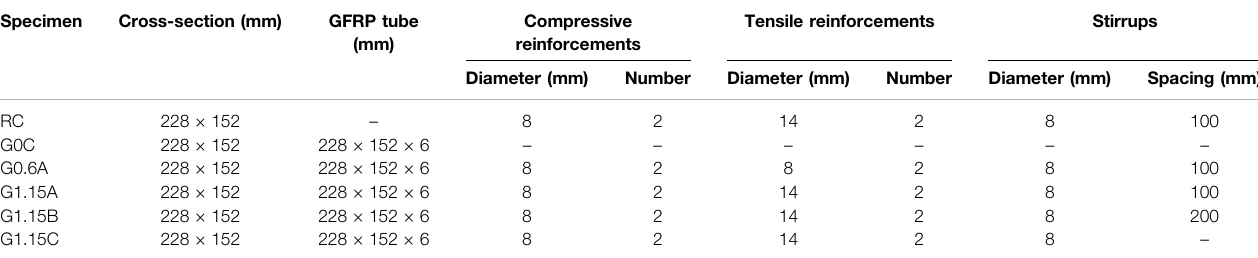
TABLE 1 | Con fi guration of beam specimens.